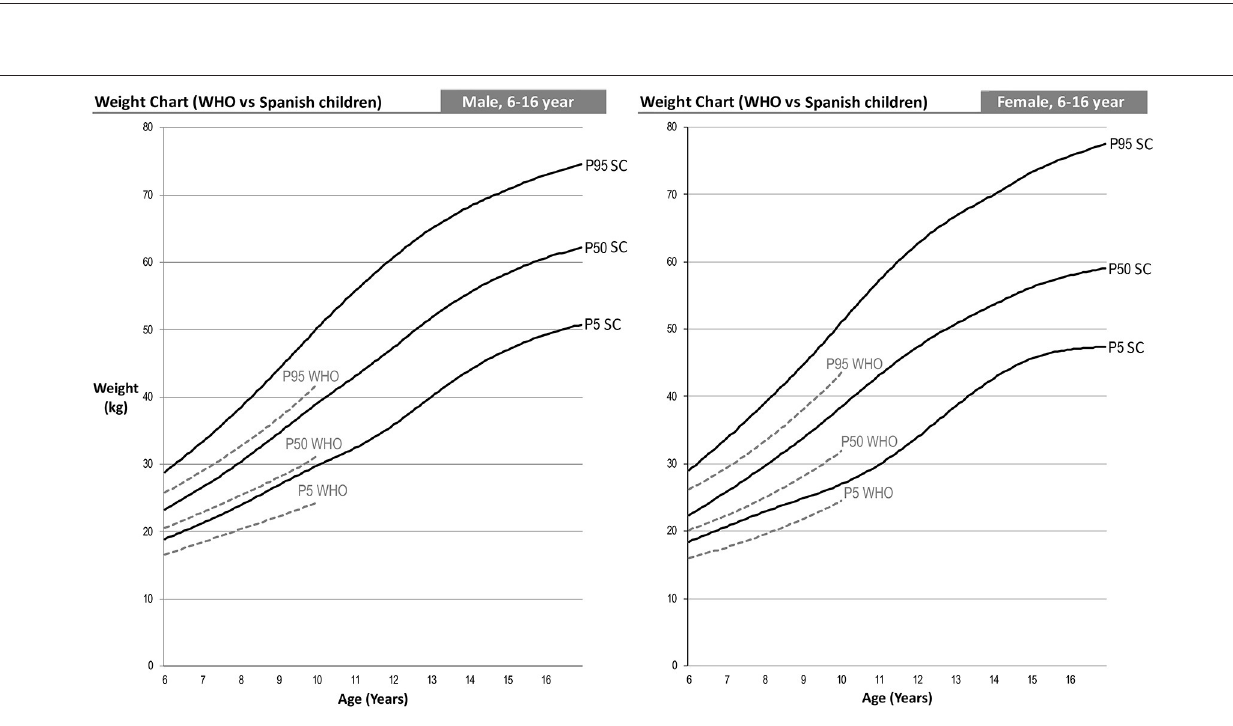
FIGURE 5 | WHO 2007 and Spanish-eastern children weight percentile comparison. Two-sample Anderson Darling test for goodness of fit of the curves: male 5th percentile (AD: 14.33; p = 0.000); Male 50th percentile (AD: 13.88; p = 0.000); male 95th percentile (AD: 10.00; p = 0.000); female 5th percentile (AD: 13.03; p = 0.000); female 50th percentile (AD: 11.22; p = 0.000); female 95th percentile (AD: 8.71; p =